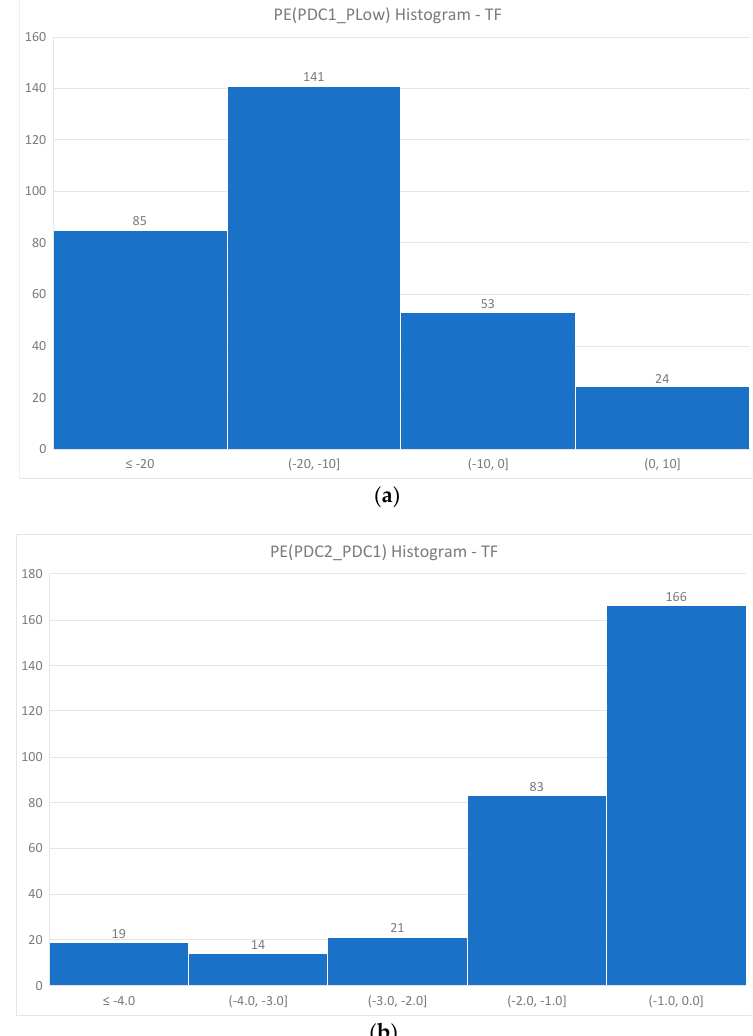
Figure 8. Histograms of the Percentage Error 𝑃𝐸 (cid:2869)(cid:3013)(cid:3042)(cid:3050) concerning 𝑃𝐷𝐶 (cid:2869)(cid:3013)(cid:3042)(cid:3050) and 𝑃 (cid:3013)(cid:3042)(cid:3050) ( a ), and the Percentage Error 𝑃𝐸 (cid:2870)(cid:3013)(cid:3042)(cid:3050) concerning 𝑃𝐷𝐶 (cid:2870)(cid:3013)(cid:3042)(cid:3050) and 𝑃𝐷𝐶 (cid:2869)(cid:3013)(cid:3042)(cid:3050) ( b ); polycrystalline modules.